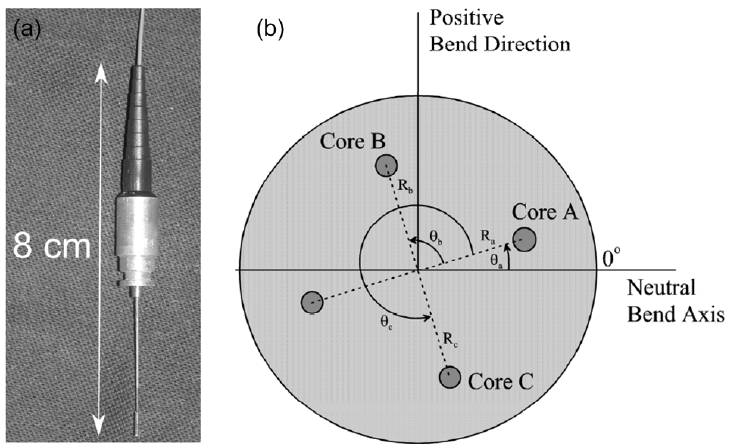
Figure 18. ( a ) The packaged MCF inclinometer. ( b ) Core geometry of the MCF. Bend direction denotes the direction of positive radii of curvature (end of the fiber points down). Neutral bend axis defines the plane of bending. The cores are labeled with their respective core radii and angular offsets from 0°. Figure reproduced from Ref. [54] © SPIE.